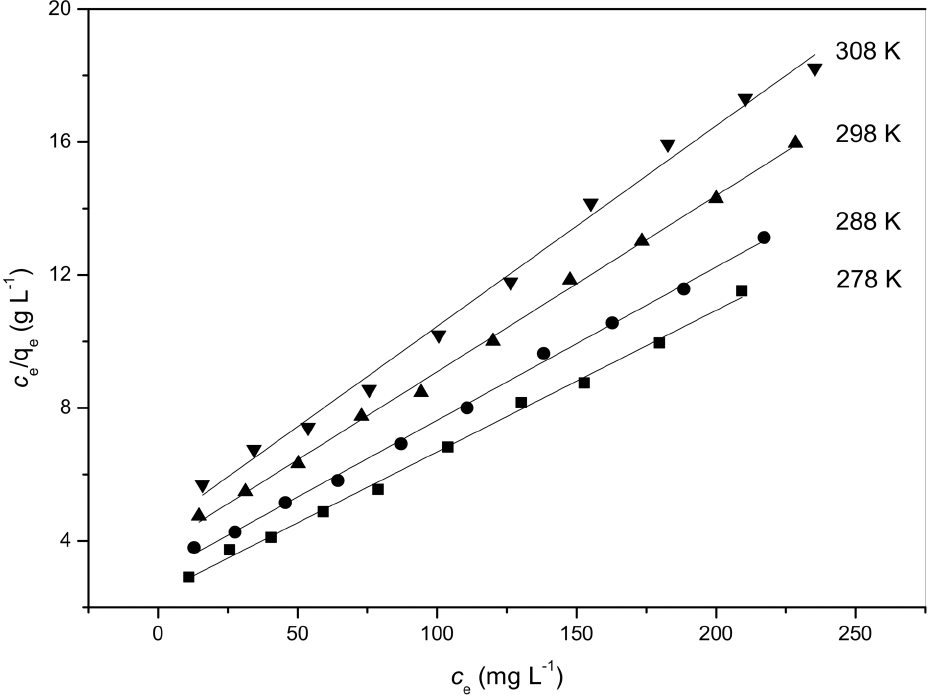
Figure 4. Langmuir isotherm plots for Cd 2 + biosorption at different temperatures.